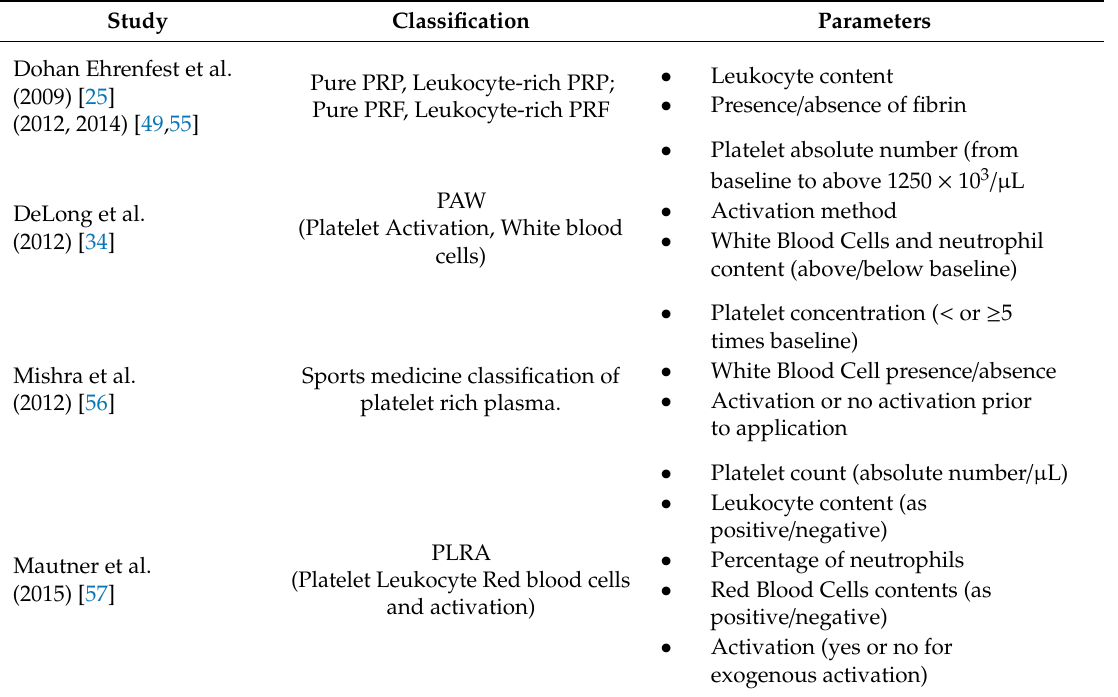
Table 2. Summary of classification systems for platelet concentrates